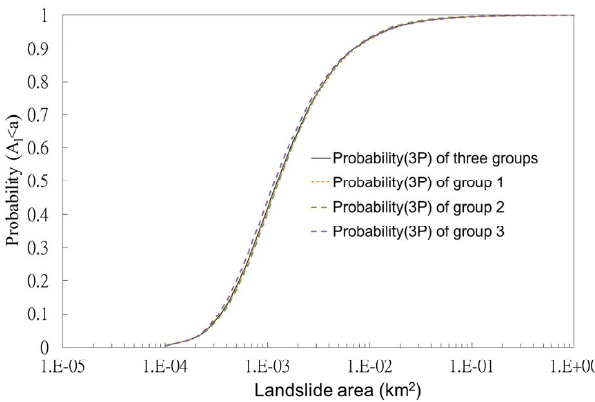
Fig. 9. Cumulative probability of landslide area exceeding a certain size threshold based on Pearson type 5 (3P) Distribution. 4